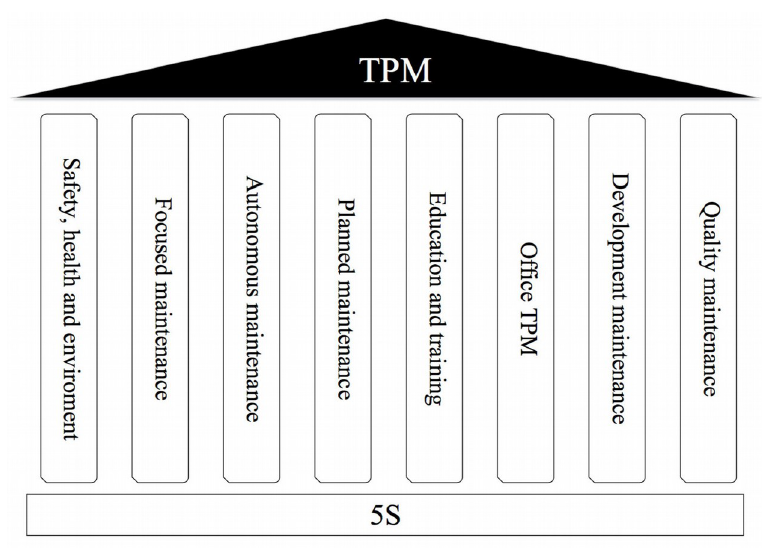
Figure 1. House of TPM (Pacaiova & Izarlkova,